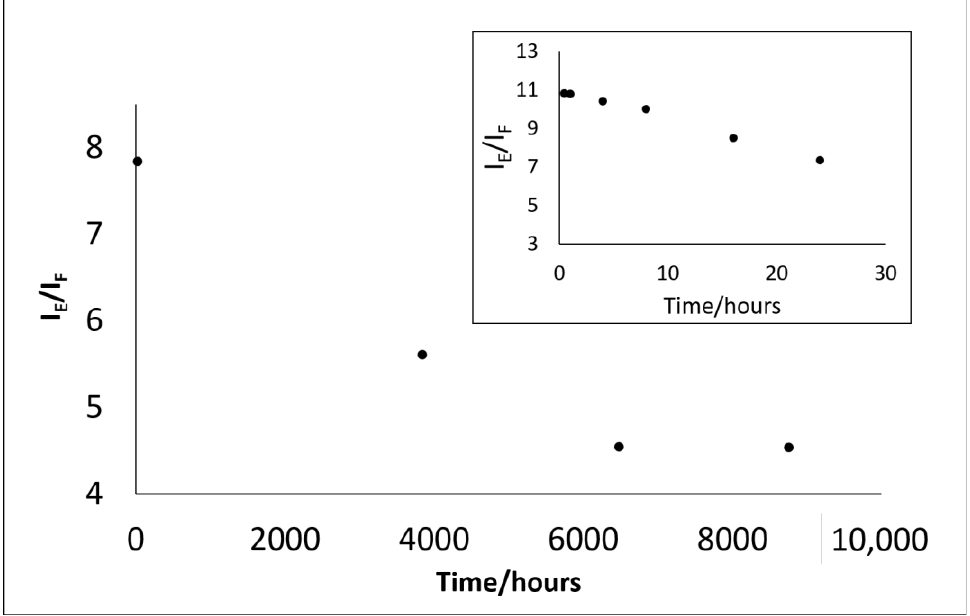
Figure 10. Diagram of the ratio of intensities of IR bands ν 2 and ν 4 of the carbonate group ( I E /I F )